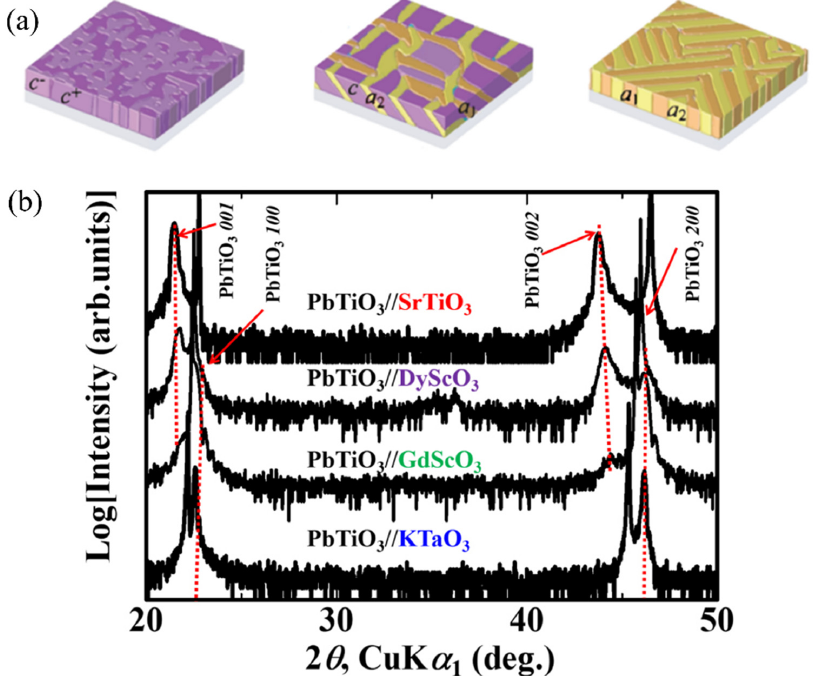
Figure 8. Domain structures at different misfit strains. ( a ) Domain structures in BaTiO 3 films at different misfit strains by phase field simulation [102]. The lattice mismatches are − 1.0%, 0.0%, and 0.2% from left to right. The domain structures are c-domains, a/c-domains, and a-domains, respectively. ( b ) Domain structures in PbTiO 3 films with different substrates [113]. The lattice